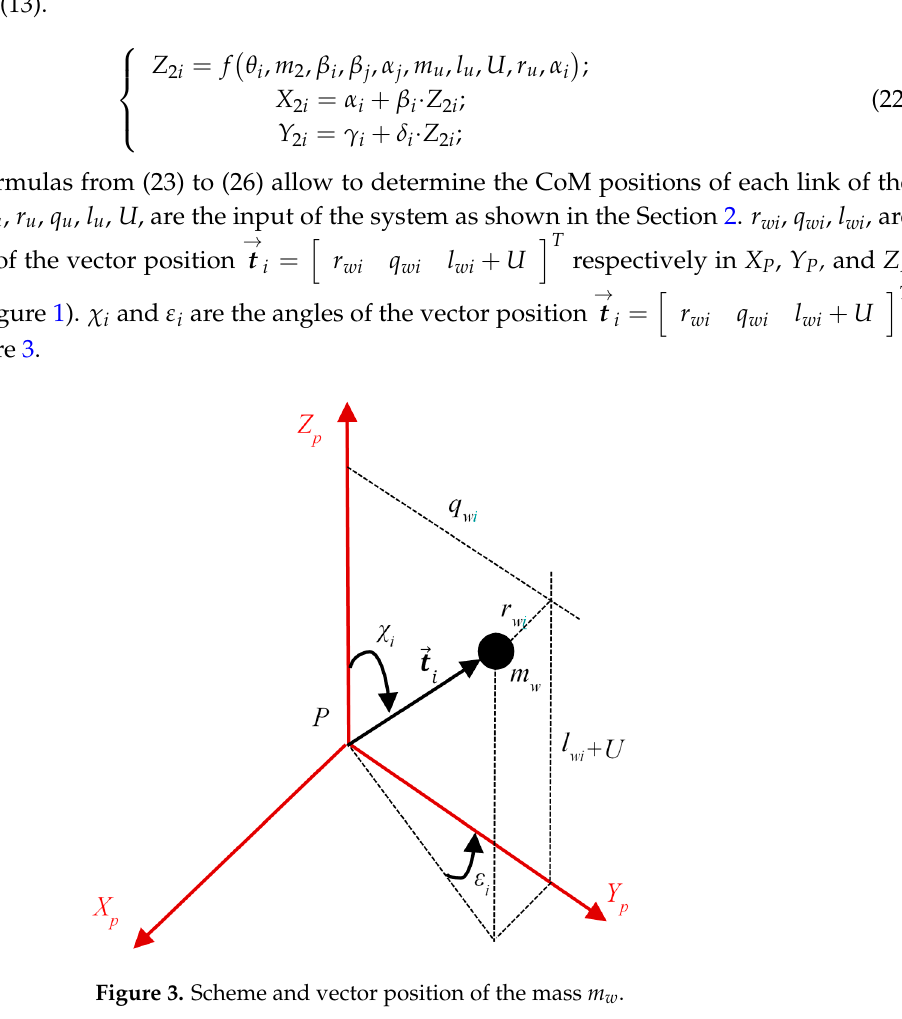
Figure 3. Scheme and vector position of the mass m w